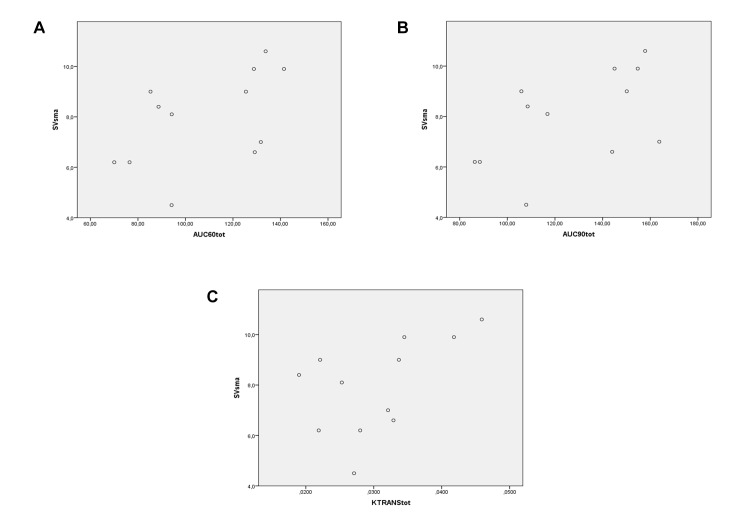
Spearman rank correlation analysis.Correlation between MRI perfusion parameters (on the horizontal axis)—AUC60 (A), AUC90 (B), and Ktrans (C)—in the whole small bowel—of PNH patients and SV of SMA (on the vertical axis).